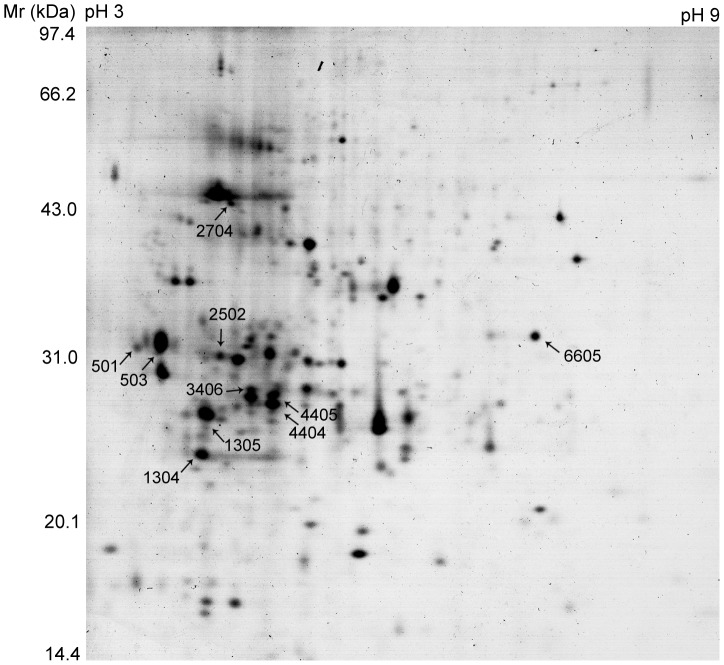
Coomassie Brilliant Blue stained 2D-PAGE gel of proteins in potato leaf cells treated with glucopentaose.2D-PAGE separation was performed in the first dimension on a linear pH 3–10 IPG strip, and in the second dimension on a 12.5% polyacrylamide gel. The spots were numbered automatically by the Bio-Rad PDQuest software. The gel ranging from pH 9 to pH 10 was truncated as no visually detected spot was found within this region.